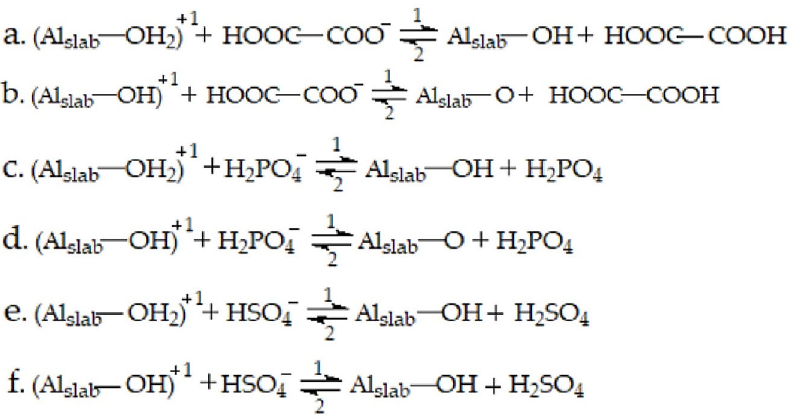
Figure 3. The equations of acid radicals stripping off H in H 2 O on the anodic aluminum slabs. Table 4. The E str (eV) values of acid radicals stripping off one of the H in H 2 O. The a, b, c, d, e and f correspond to the labels of reactions in Figure 3. Subscript “1” is for the direction of reactions in Figure